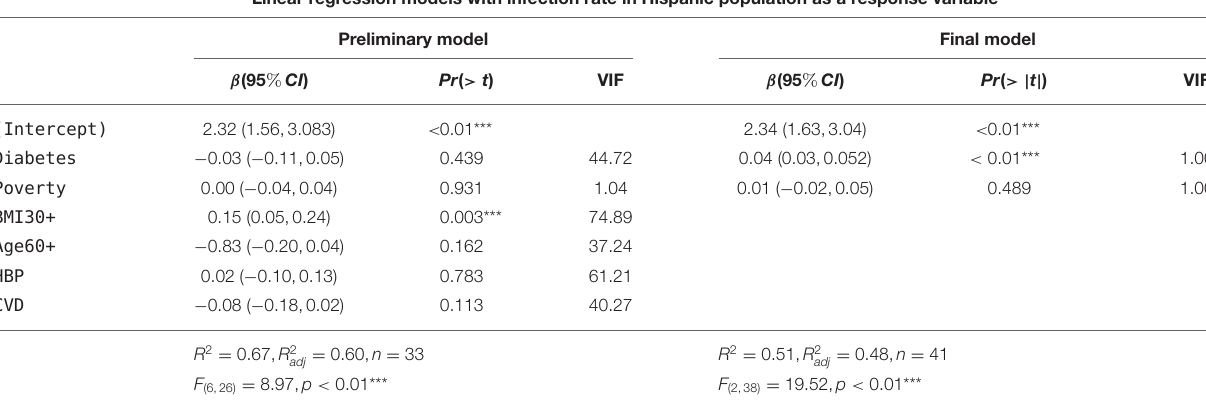
TABLE 8 | Linear models with infection and mortality rates as response variables for Hispanic. Linear regression models with infection rate in Hispanic population as a response variable Preliminary